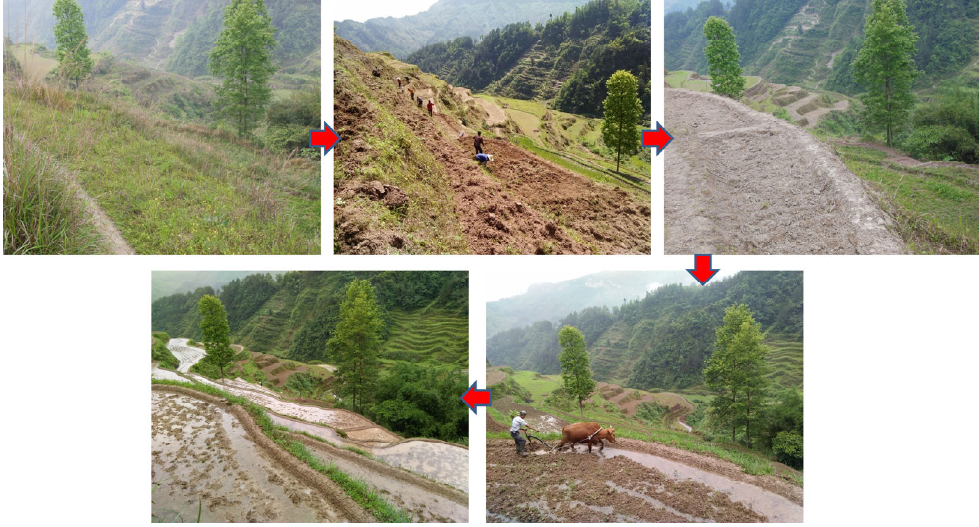
Figure 1. The engineering processes of new paddy field construction.